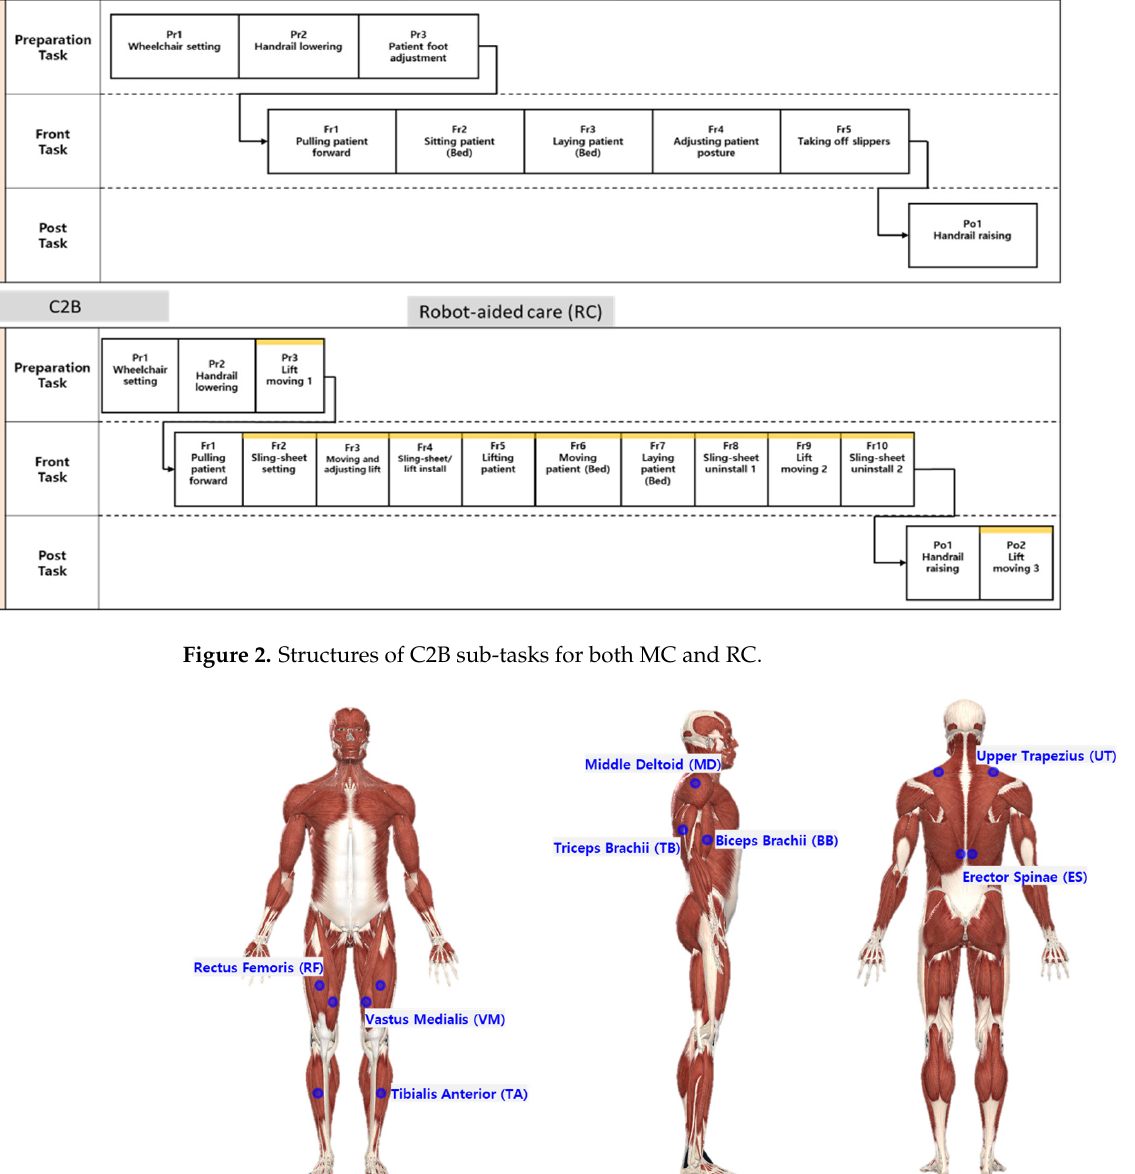
Figure 2. Structures of C2B sub-tasks for both MC and RC.